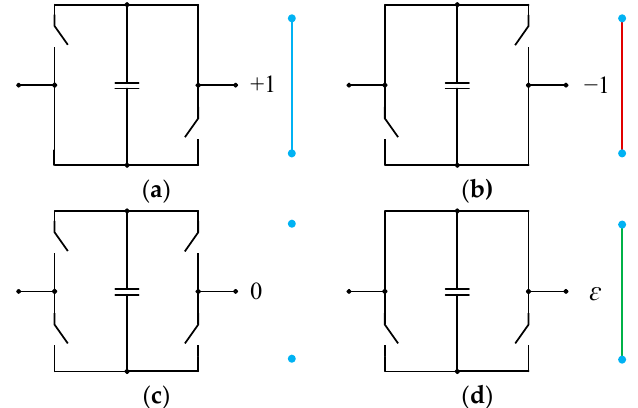
Figure 6. Operating status of lattice converter H-bridge submodules: ( a ) Positive output +1; ( b ) Negative output − 1; ( c ) Off 0; ( d ) Zero-output ε .